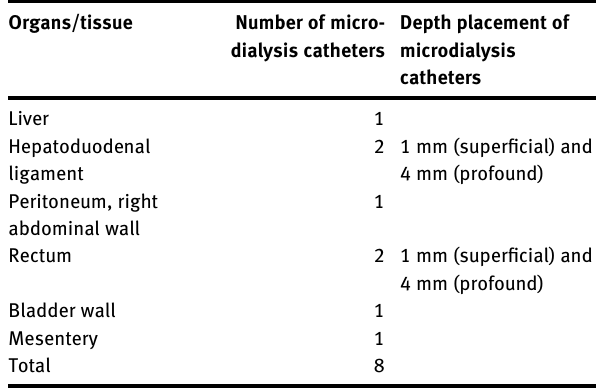
Table  : Placement of microdialysis catheters in the investigated solid tissues within the